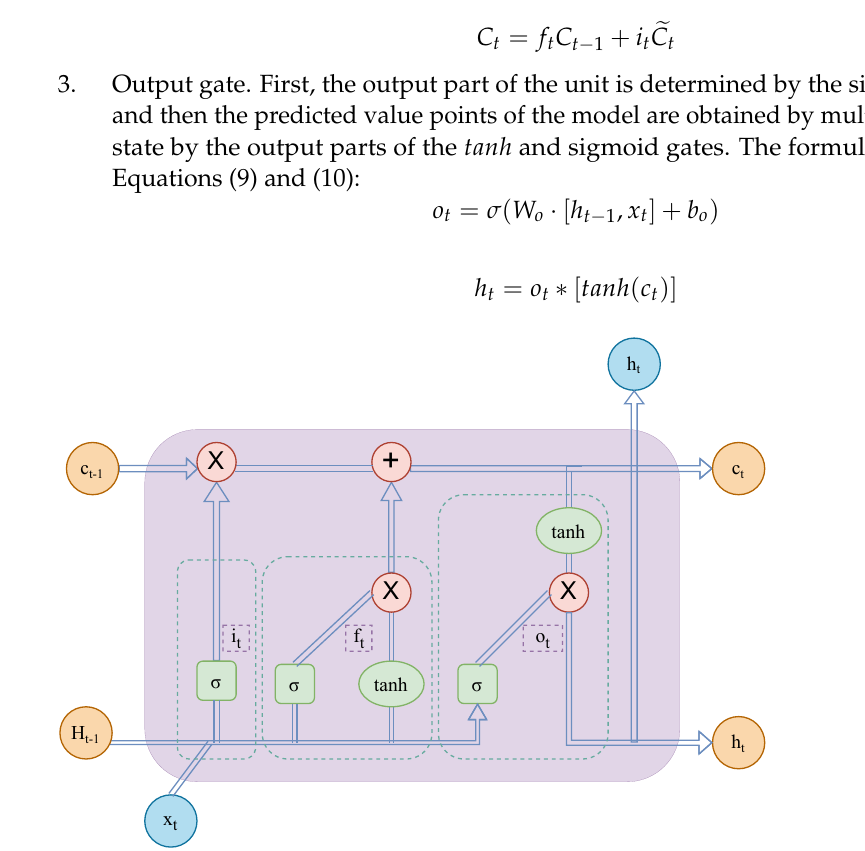
Figure 2. The schematic diagram of the working process of the LSTM neural